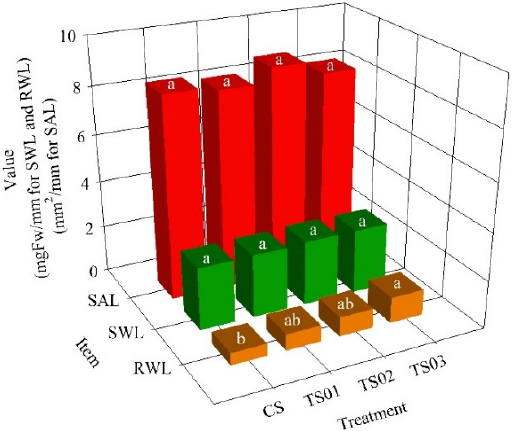
Figure 3. Plantlet growth characteristics of shoot surface area per unit length (SAL; surface area shoots /Length shoots ), shoot weight per unit length (SWL; FW shoots /Length shoots ), and root weight per unit length (RWL; FW roots /Length main root ) of Hylocereus polyrhizus ‘Da Hong’ grown on Murashige and Skoog (MS) medium supplemented with α-naphthaleneacetic acid (NAA) alone. Treatments: CS, control; TS01, 0.05 mg/L NAA; TS02, 0.10 mg/L NAA; TS03, 0.20 mg/L NAA. Mean ± SE ( n = 3, 5 segments per replicate). Means followed by different letters near the column are significantly different at p = 0.05 using Fisher’s protected LSD test.